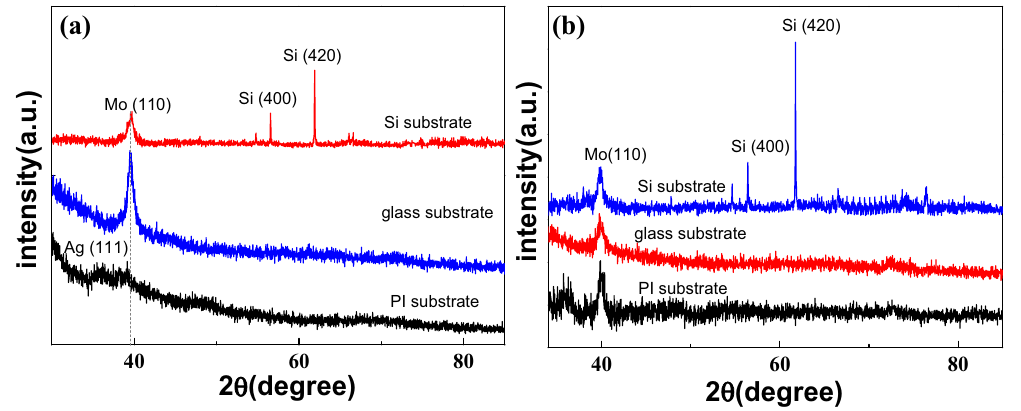
Figure 2: The XRD patterns of Ag – Mo alloy fi lms deposited on di ff erent substrates by di ff erent sputtering methods: ( a ) composite target sputtering and ( b ) co -